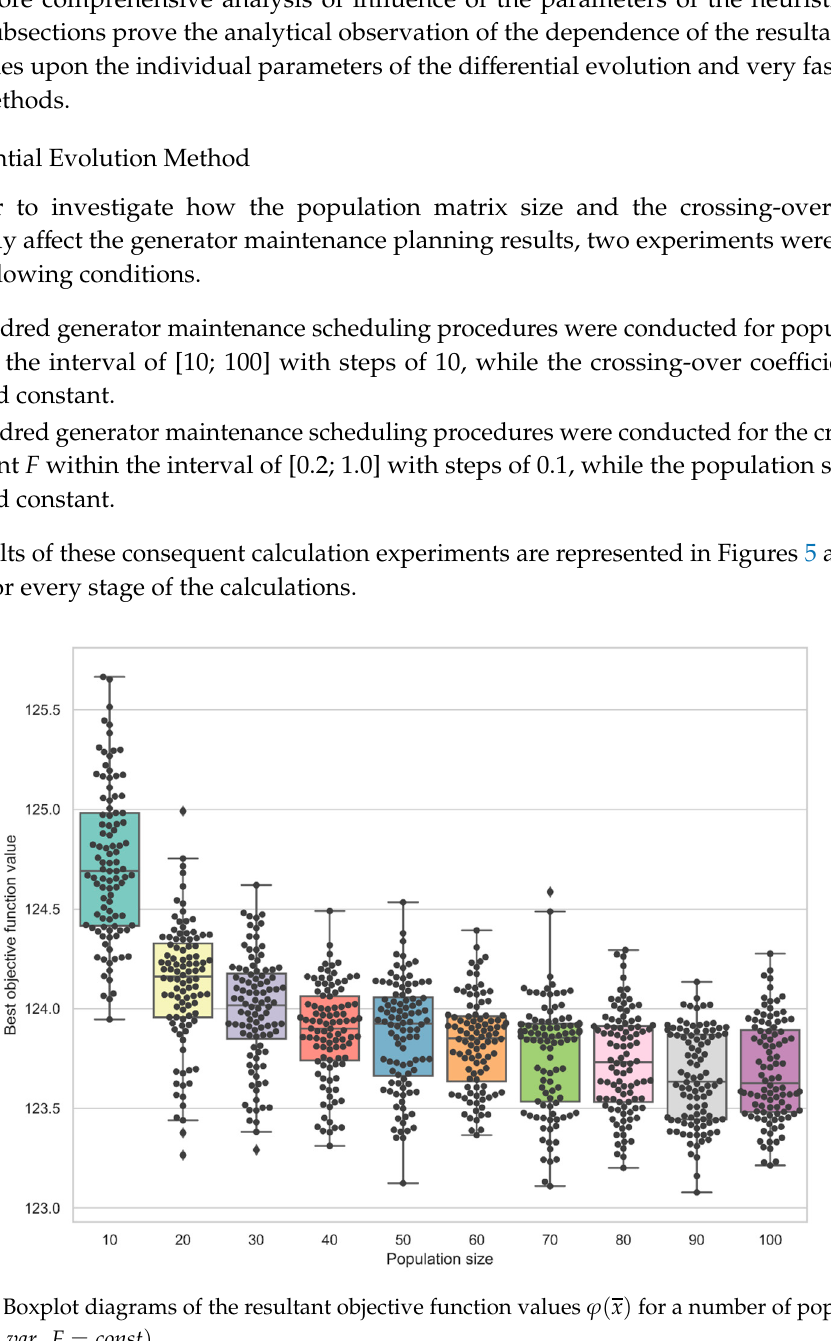
Figure 6. Boxplot diagrams of the resultant objective function values 𝜑(𝑥̅) for a number of crossing- over coefficients ( 𝑠 = 𝑐𝑜𝑛𝑠𝑡, 𝐹 = 𝑣𝑎𝑟) .